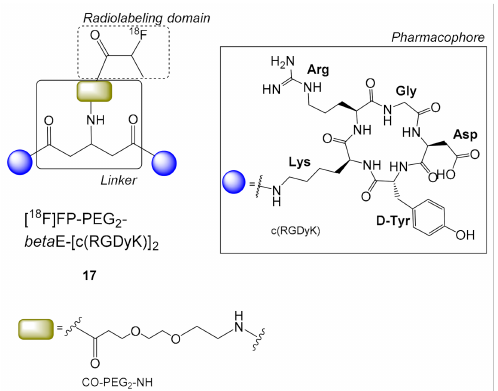
Figure 5. Chemical structure of the symmetric dimer [ 18 F]FP-PEG 2 - β -E[c(RGDyK)] 2 17 . (H 2 N-PEG 2 - COOH = 3-(2-(2-aminoethoxy)ethoxy)propanoic acid).